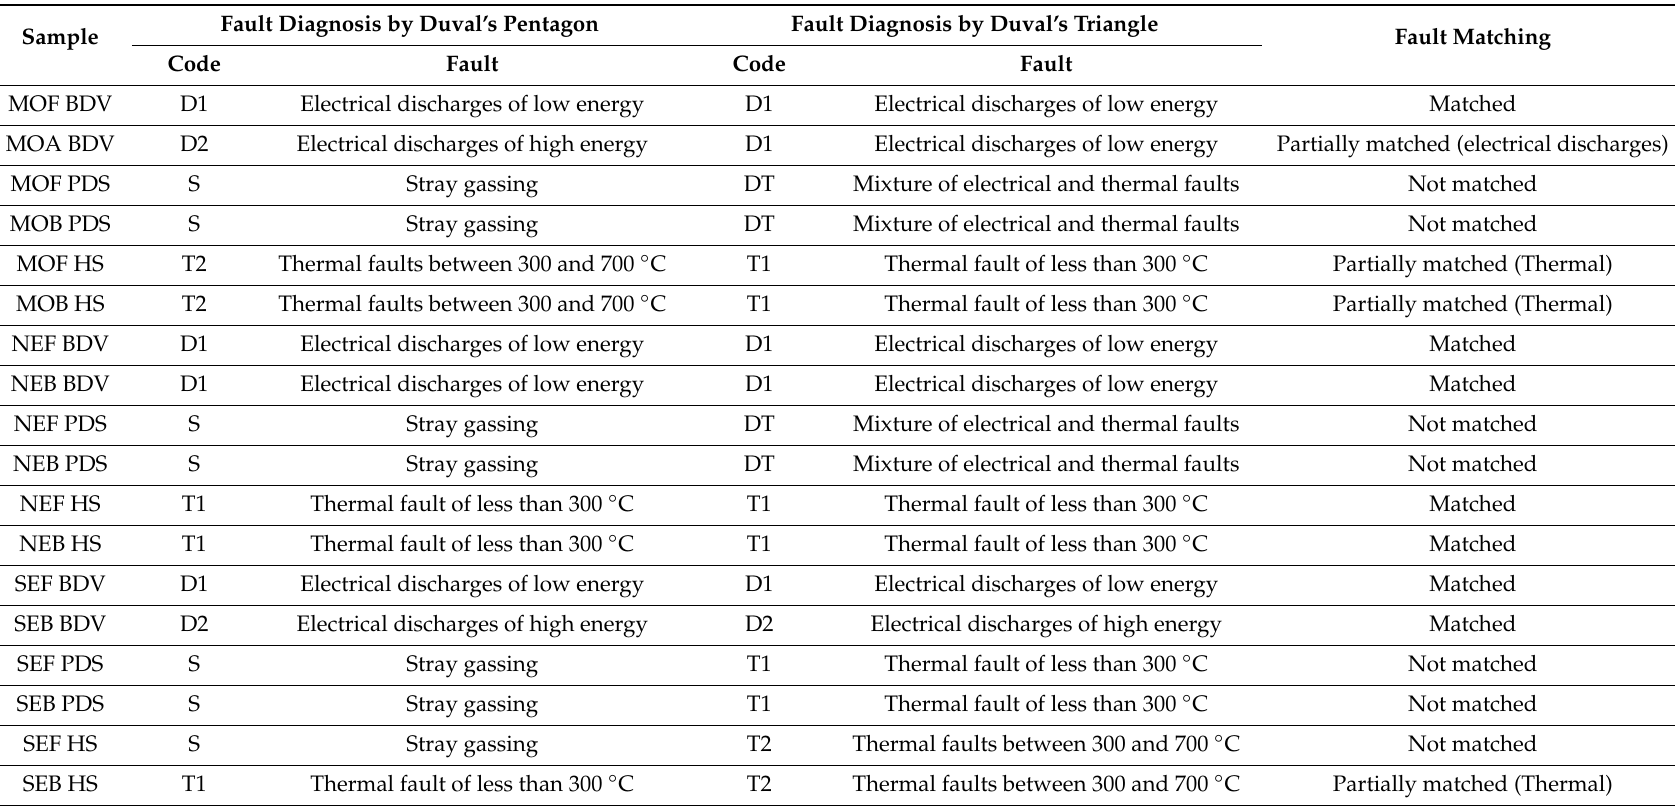
Table 5. Fault diagnosis details for Duval’s triangle and Duval’s